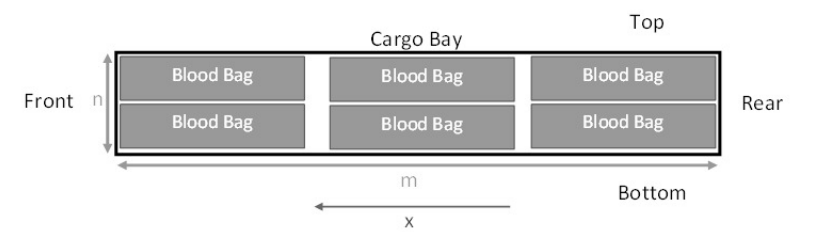
Figure 12. Bags arrangement inside cargo